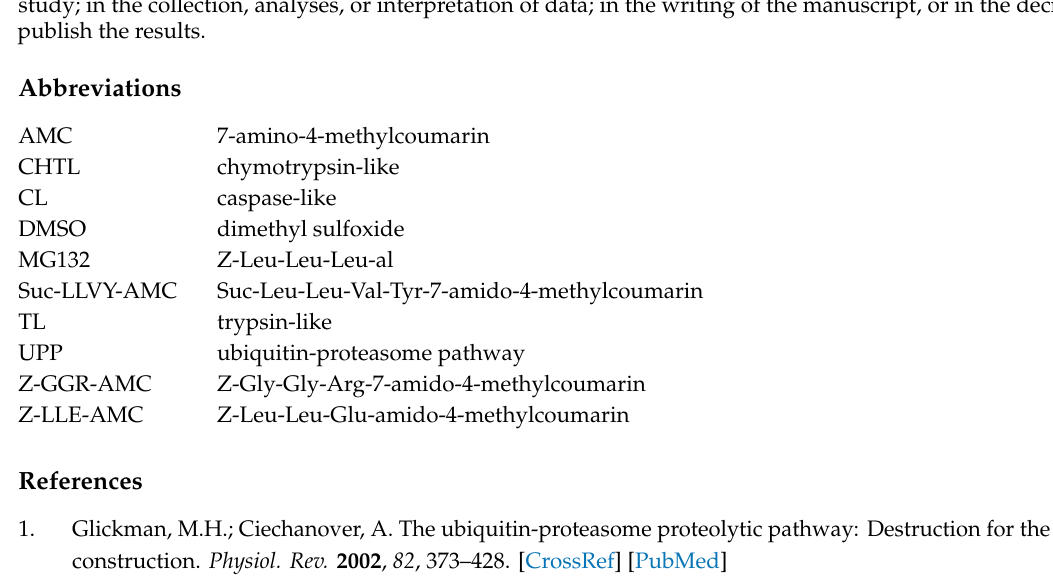
s1. Figure S1: Control reaction of β -casein degradation with no proteasome